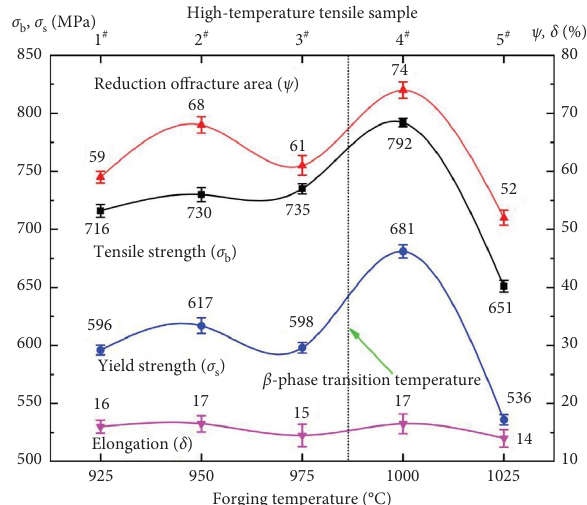
Figure 4: High-temperature mechanical property of Ti-6Al-4V alloy at diferent forging temperatures (average value of fve forged Ti-6Al-4V alloy